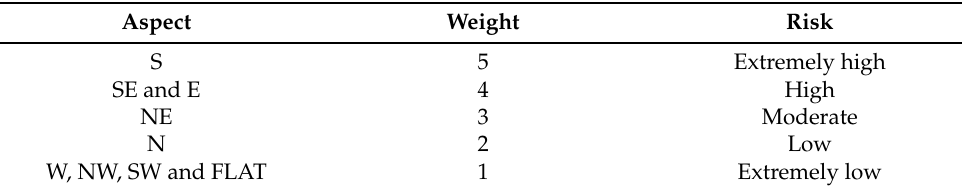
Table 4. Fire risk classification of aspect.